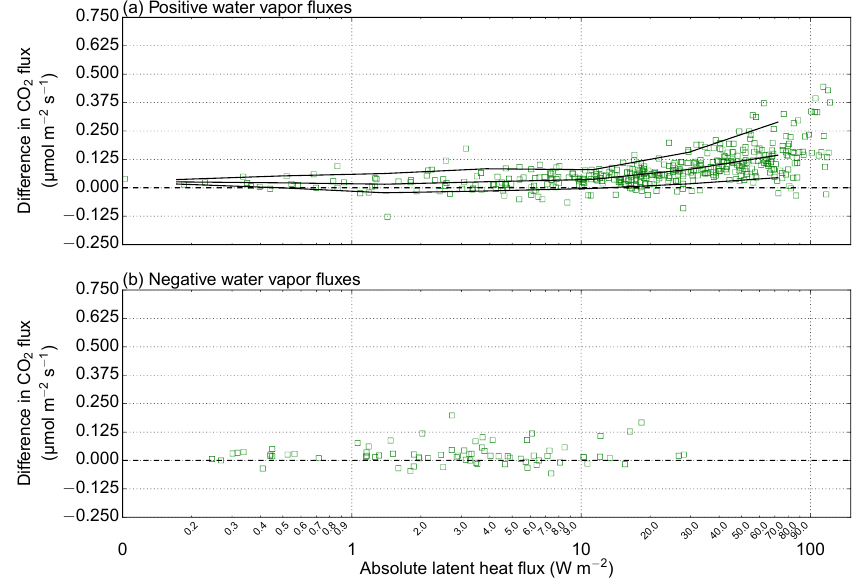
Figure 10. CO 2 flux difference (standard setup–test setup) as a function of latent heat flux for (a) positive and (b) negative water vapor fluxes. The lines show a fitted mean together with the 10th and 90th percentiles for eight logarithmically equally spaced